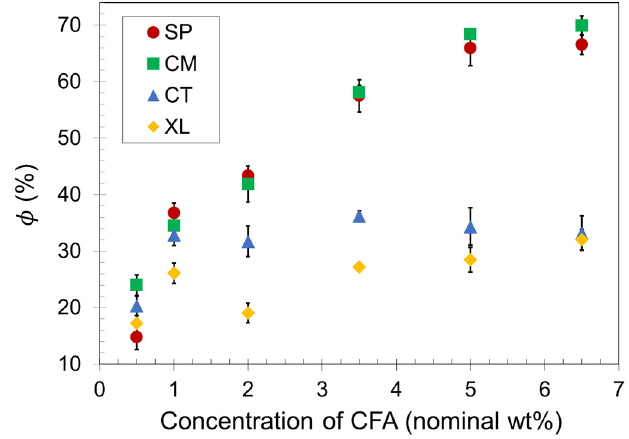
Figure 2. Void fraction of SSSP-processed (SP), cryomilled (CM), manually blended control (CT), and crosslinked/cryomilled (XL) PLA foam samples.